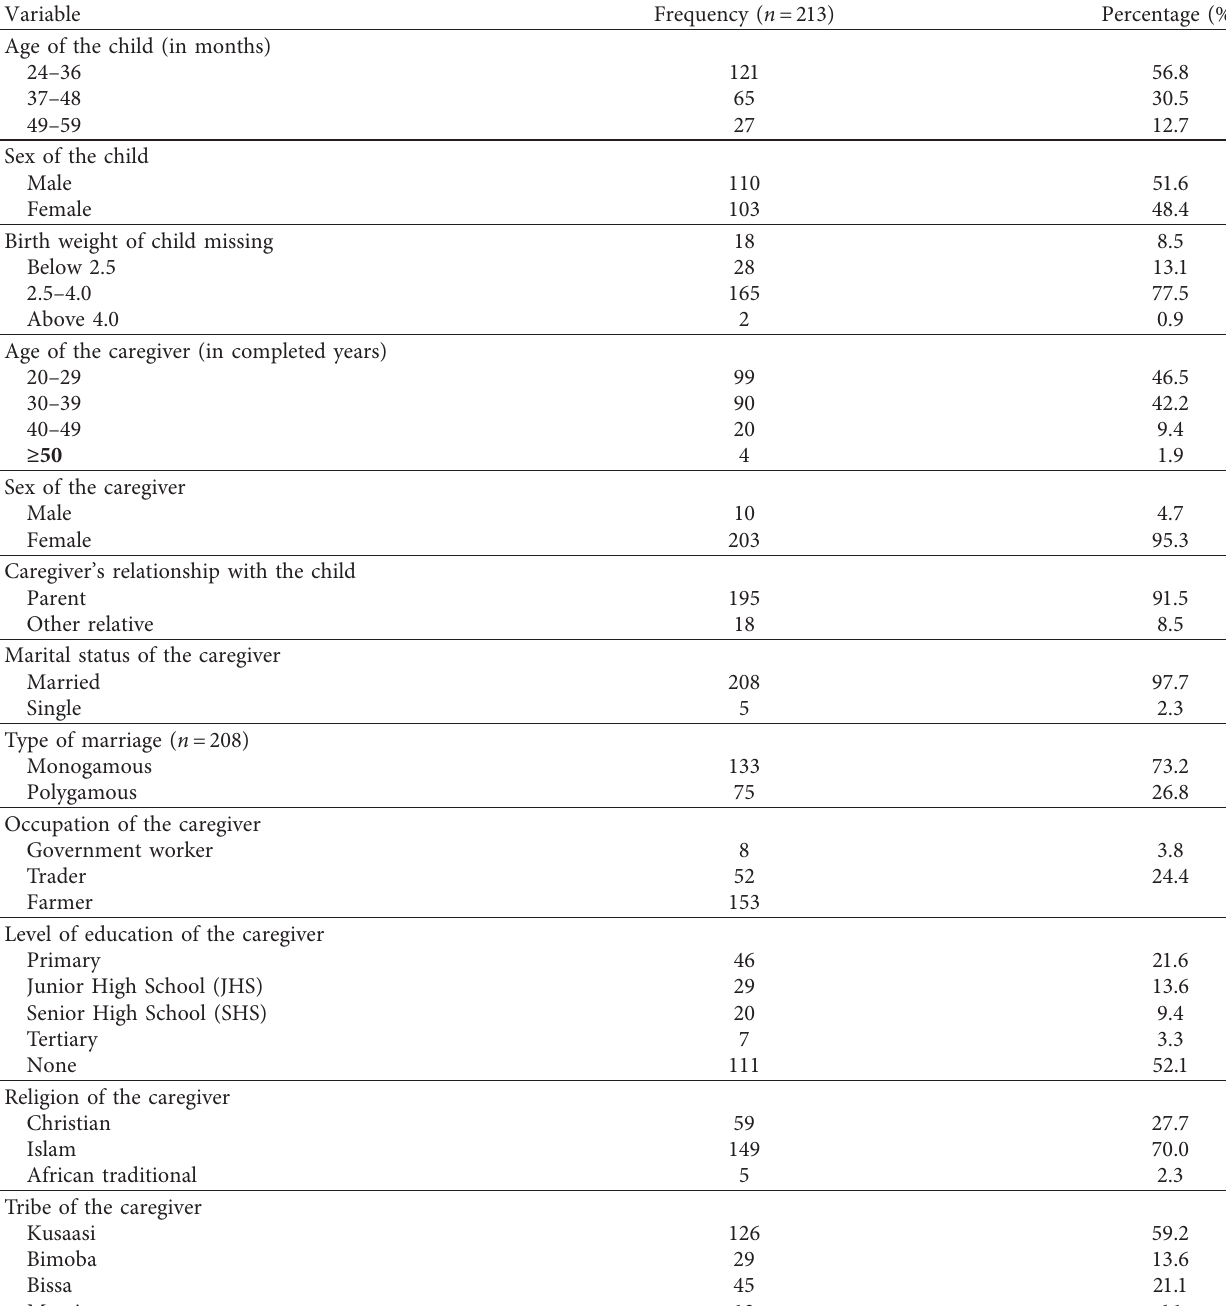
Table 2: Socio-demographic characteristics of